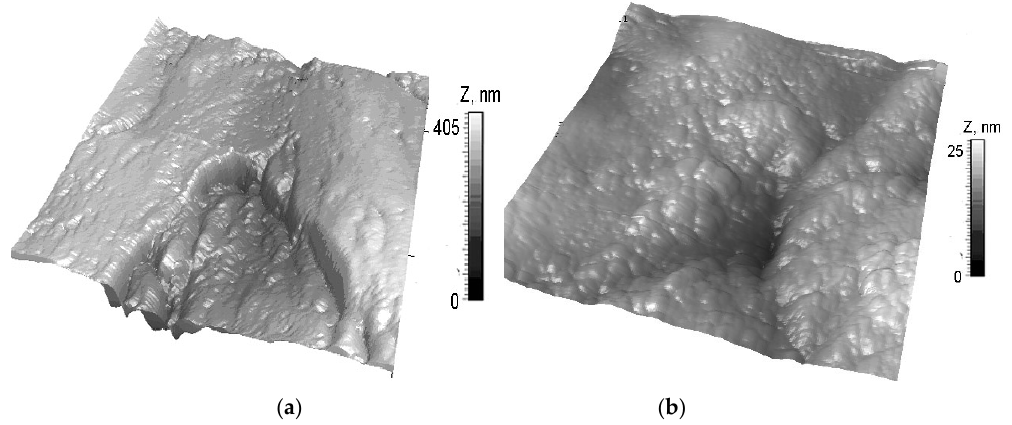
Figure 3. AFM images of a healthy human surface: ( a ) 9 × 9 µm 2 , Z max = 2500 nm, and ( b ) 3 × 3 µm 2 , Zmax = 60 nm.